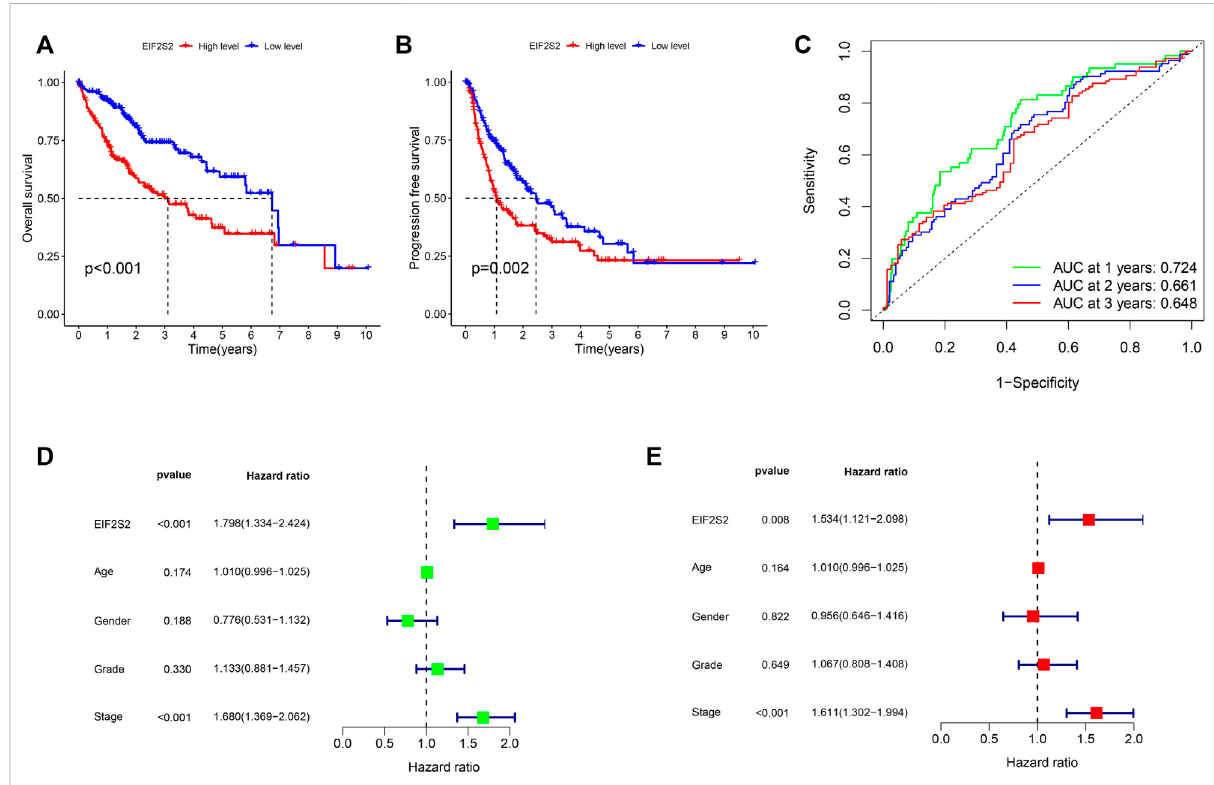
FIGURE 2 Survival and prognosis analysis of EIF2S2. (A) High EIF2S2 expression groups had a shorter OS. (B) High EIF2S2 expression groups had a shorter PFS. (C) AUC of time-dependent ROC curves to evaluate the predictive ef fi cacy of the prognostic signature for OS in HCC patients (D) EIF2S2 could act as a risk factor for survival with Multivariate cox regression analysis. (E) EIF2S2 could act as a risk factor for survival with Univariate cox regression